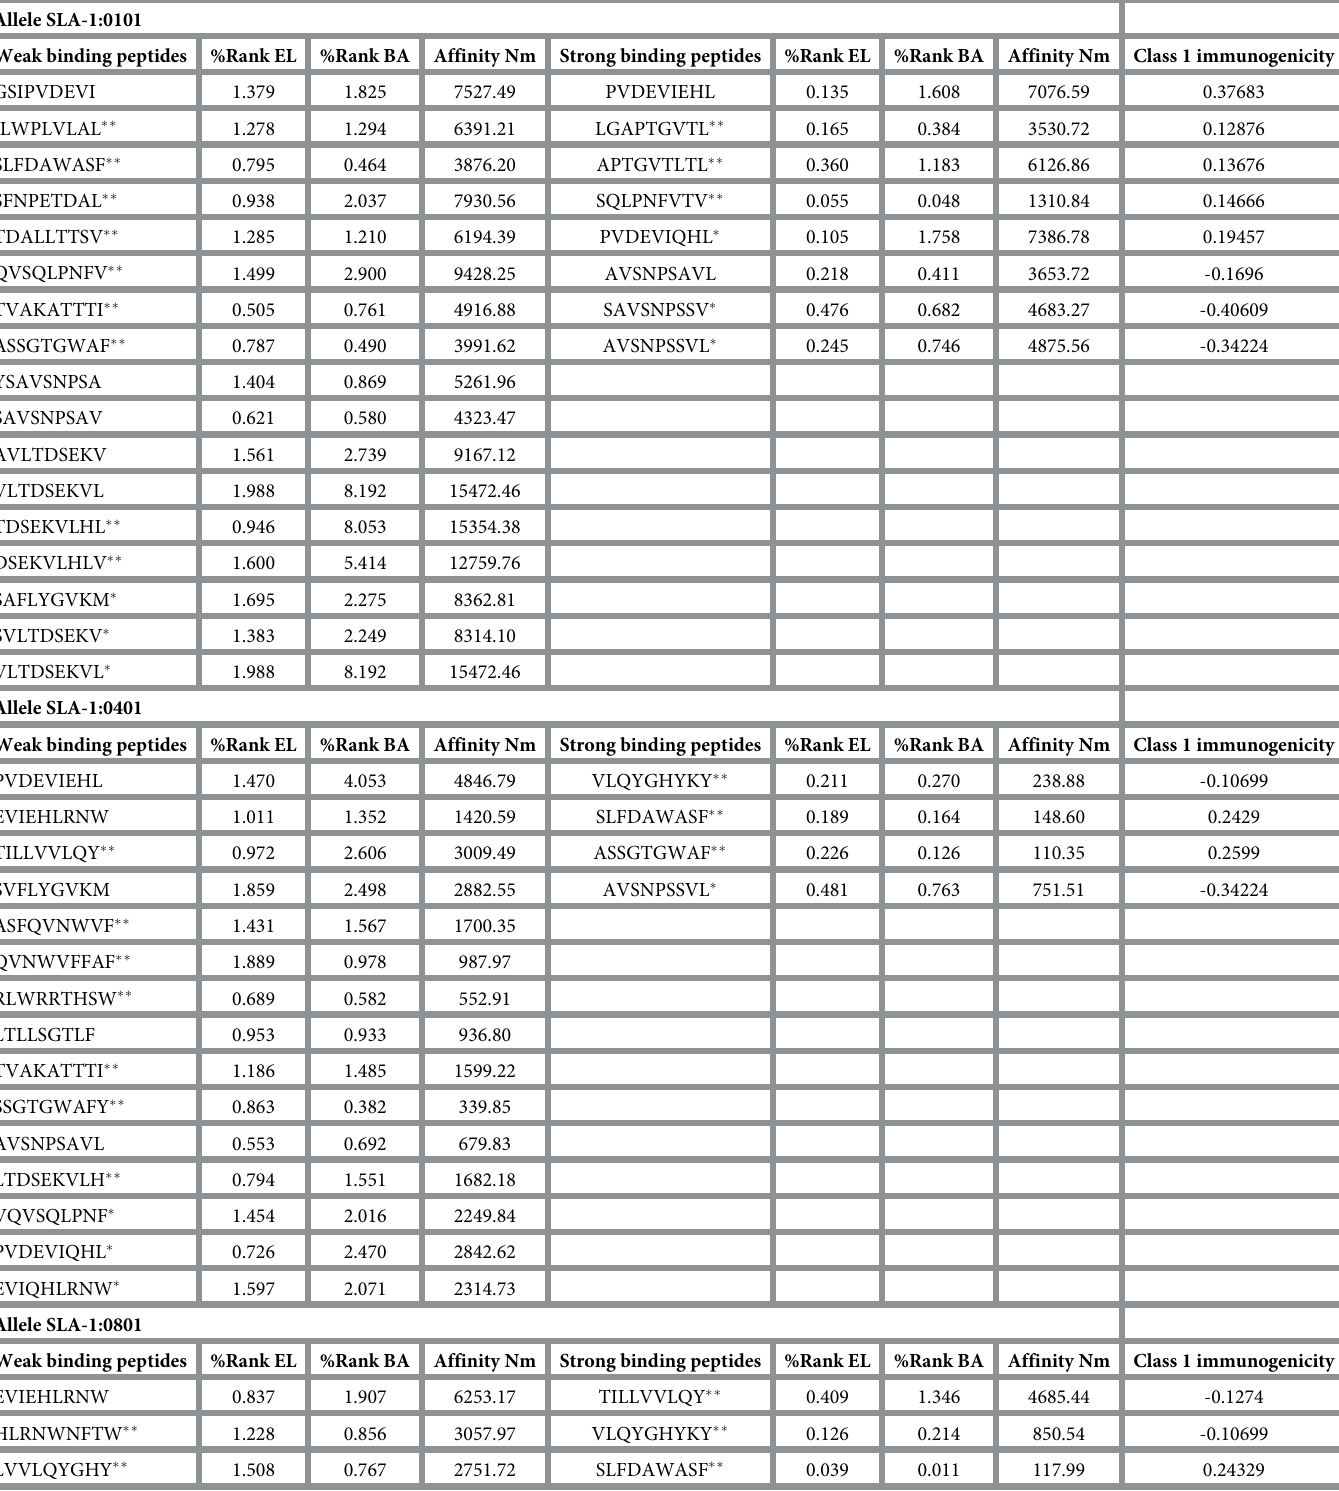
Table 2. Continuous T cell epitopes of CV777 and 2013MMV M protein. Allele